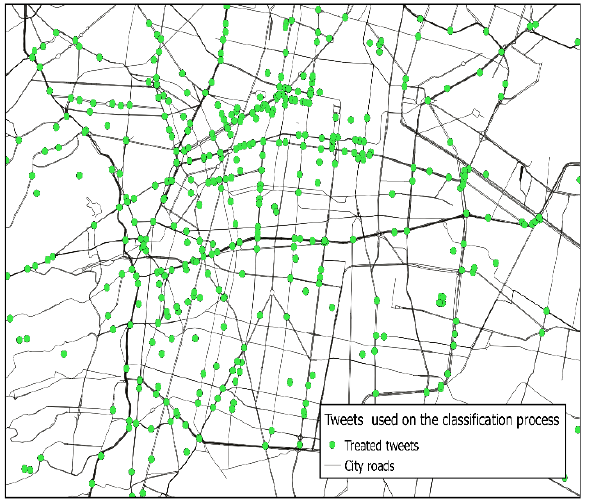
Figure 4. Tweets classified as Accidents and Closure events.